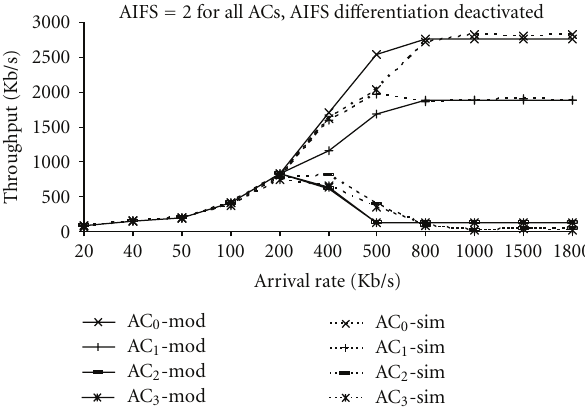
Figure 25: Total achievable throughput—TXOPlimit deactivated.